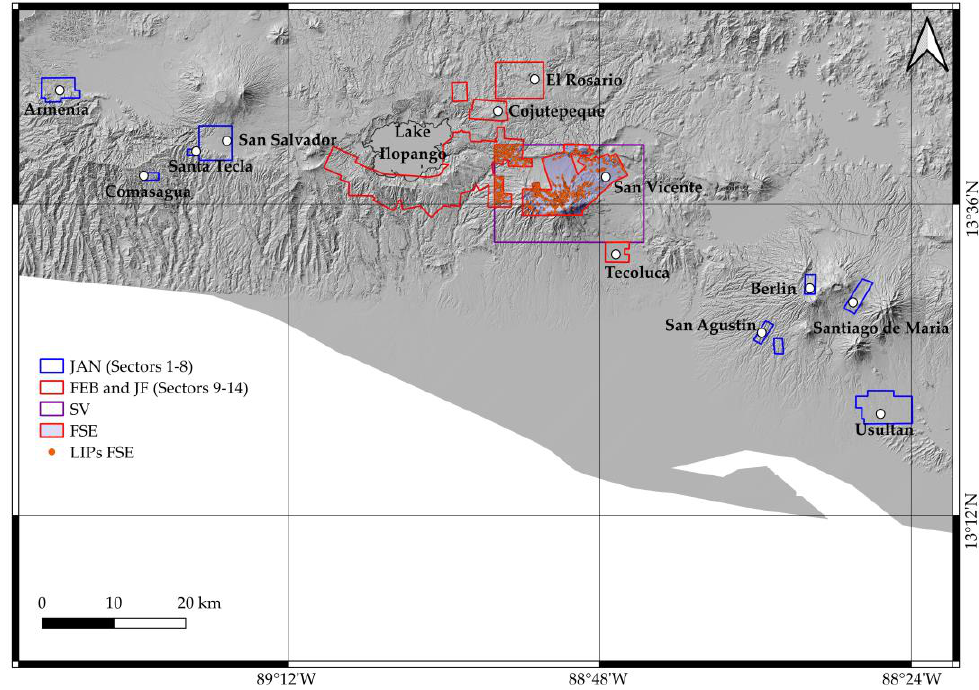
Figure 8. LIPs of the landslides triggered by the seismic event on 13 February 2001 in the intersection between FEB and SV study areas (FSE).